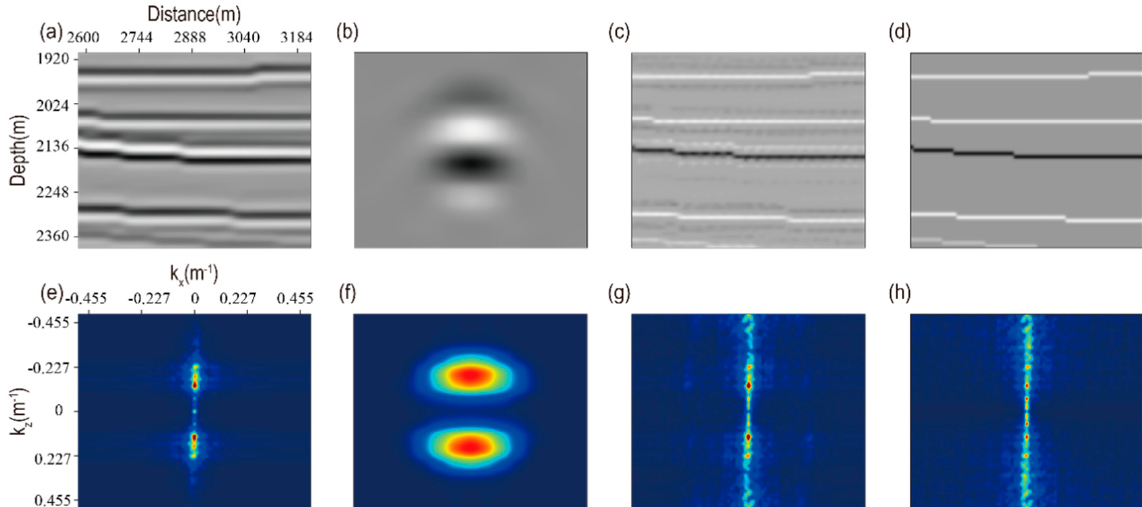
Figure 4. The sorted local imaging results (the position marked by red rectangles in Figure 3a,b) of conventional GBM ( a ), and ( b – d ) are the corresponding PSF, local corrected imaging result and the true reflectivity. The bottom four subfigures ( e – h ) are the corresponding spectrum of top four subfigures in local wavenumber domain. It is clearly seen that the conventional result has a bandlimited spectrum ( e ), while the spectrum of the corrected image ( g ) has been recovered greatly, and it is very close to the true one ( h ).